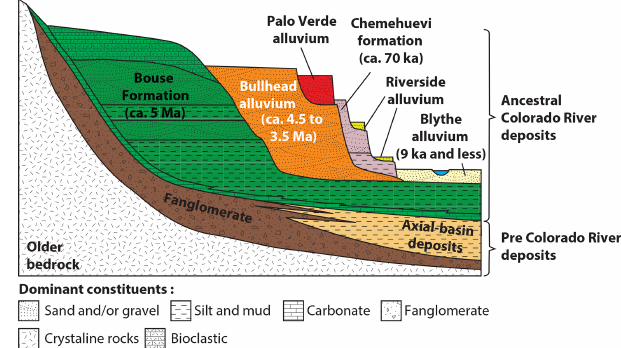
Figure 1. Simplified stratigraphic and geomorphic relationships of Neogene formations exposed in the lower Colorado River basin (af- ter Buising, 1990; Howard et al., 2015; Crow et al., 2019a). Ages for the Palo Verde alluvium (Late Pleistocene; Lundstrom et al., 2008) and the Riverside alluvium (Early(?) or Middle Pleistocene; House et al., 2018) are poorly